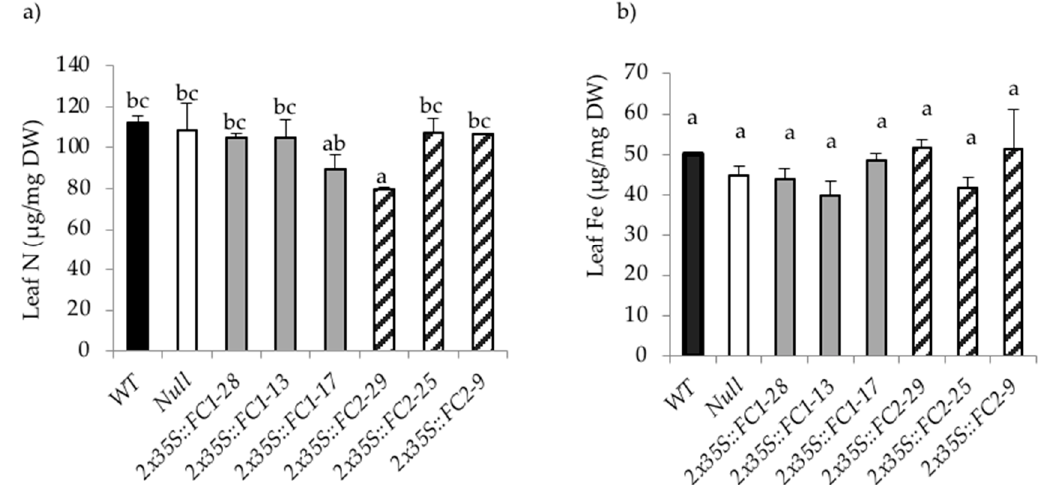
Figure 7. ( a ) Leaf n , and ( b ) Leaf total Fe concentration of transgenic barley lines over-expressing either HvFC1 or HvFC2 relative to WT and null controls. Data are shown as mean values ± standard error from three different plants. Means with the same letter are not significantly different at p < 0.05, one-way ANOVA.